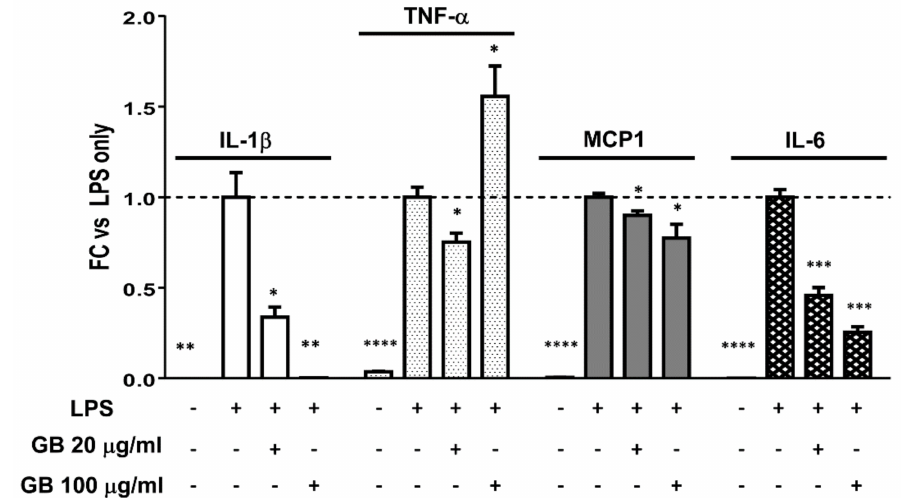
Figure 6. Groundsel bush reduces LPS-induced expression of some, but not all inflammatory genes in RAW macrophages. RAW 264.7 cells were treated for two hours with vehicle (DMSO) or GB at 20 or 100 µ g/mL; LPS was then added to a final concentration of 1 µ g/mL. Cells were incubated for six additional hours, then harvested for RNA extraction and subsequent RT-qPCR. Target gene quantities were normalized to the reference gene, ubiquitin B. * indicates p < 0.05; ** indicates p < 0.01; *** indicates p < 0.001; **** indicates p < 0.0001 vs. LPS-treated controls. n = 3 replicate wells per